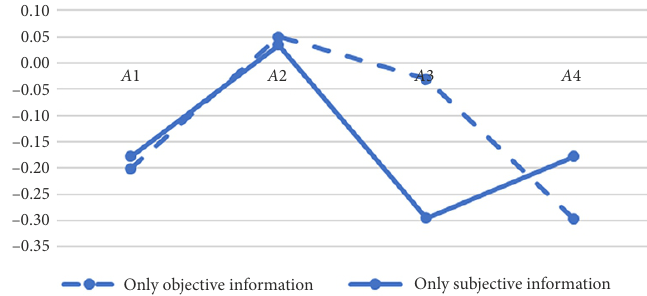
Only objective information Only subjective Figure 5. The comparision on the net flow